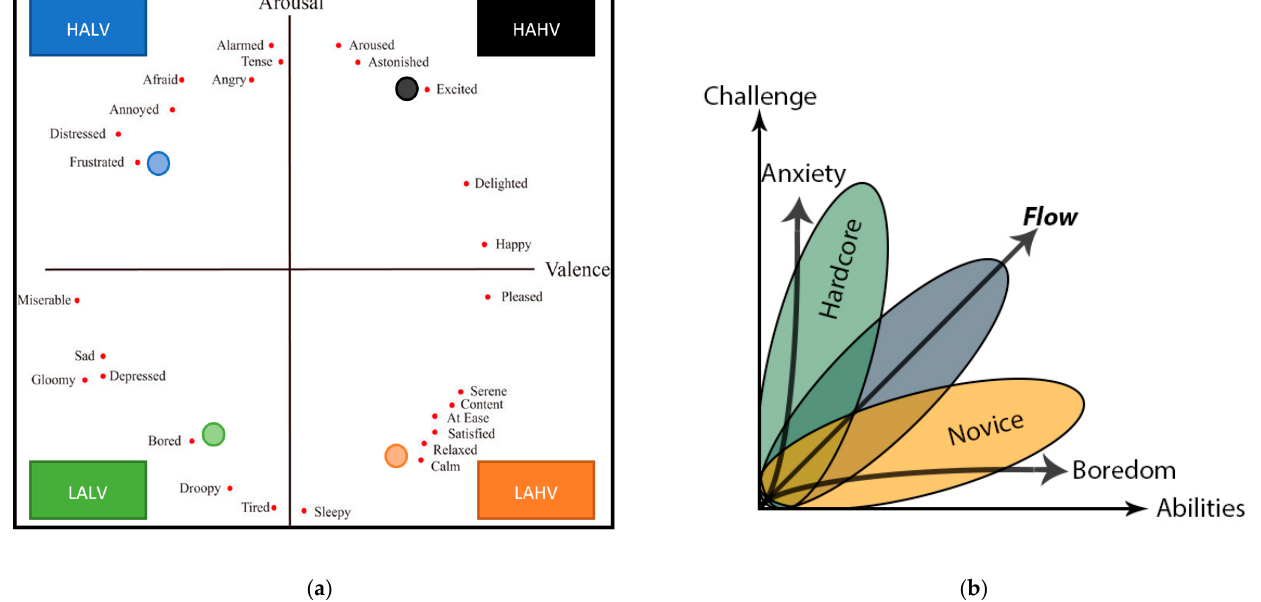
Figure A1. ( a ) Russell’s circumflex model of emotions, where the emotions selected are highlighted in the different quadrants of the two-dimensional plane [18]. ( b ) Player in-game flow experience [57].